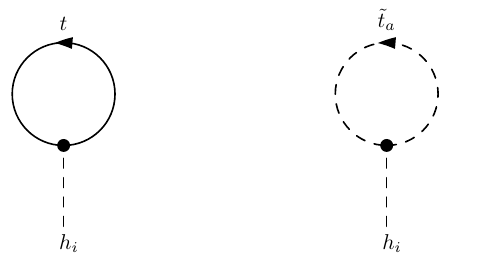
Figure 2 . One-loop tadpole diagrams of the neutral Higgs bosons h i ( i = 1 ; : : : ; 5). A summation over the index a = 1 ; 2 of the internal stop is